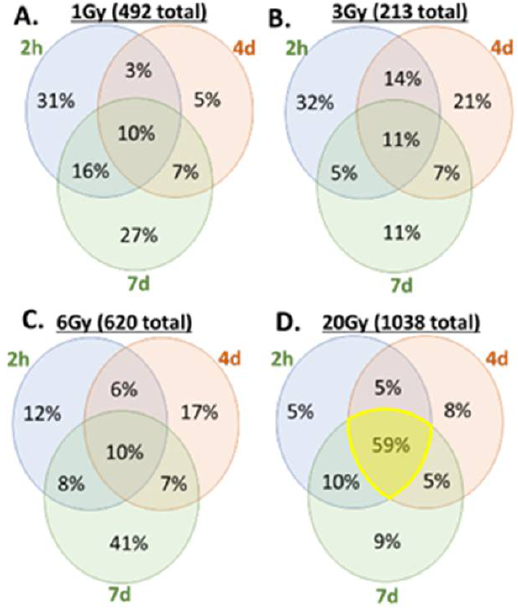
Figure 4. Venn diagrams for SDTGs’ distribution among the time points of BLDs ( D ) and corresponding BSD ( A – C ) time points (i.e., h2, d4, and d7).